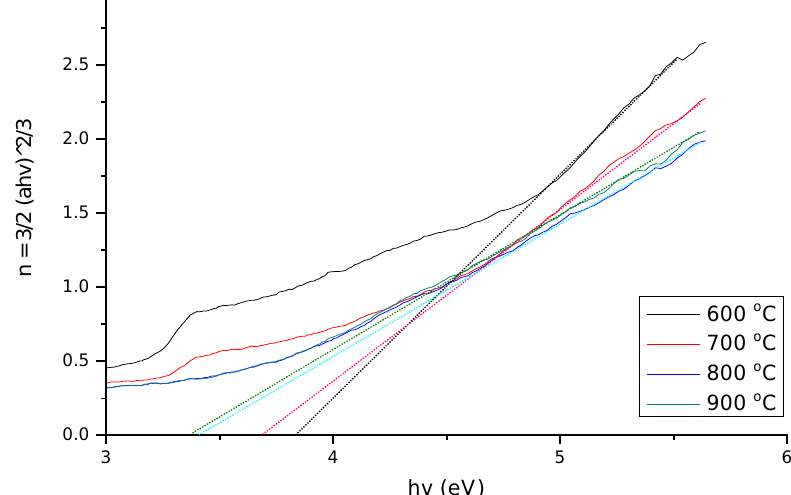
Figure 5. A plot of the optical band gap of 55ZnO–5B 2 O 3 –40SLS glass and glass-ceramic samples at various heat-treatment temperatures. Table 3. Variation of optical band gap against heat-treatment temperature.